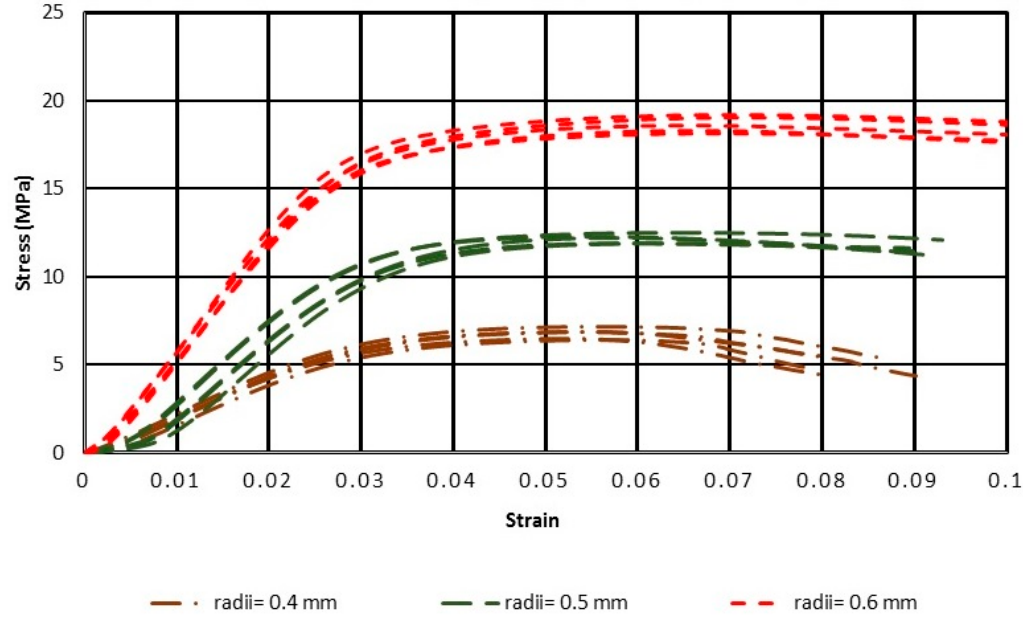
Figure 5. Stress–Strain diagram for the five samples with H/W = 4, of octet, with radii of struts 0.4, 0.5, and 0.6 mm.